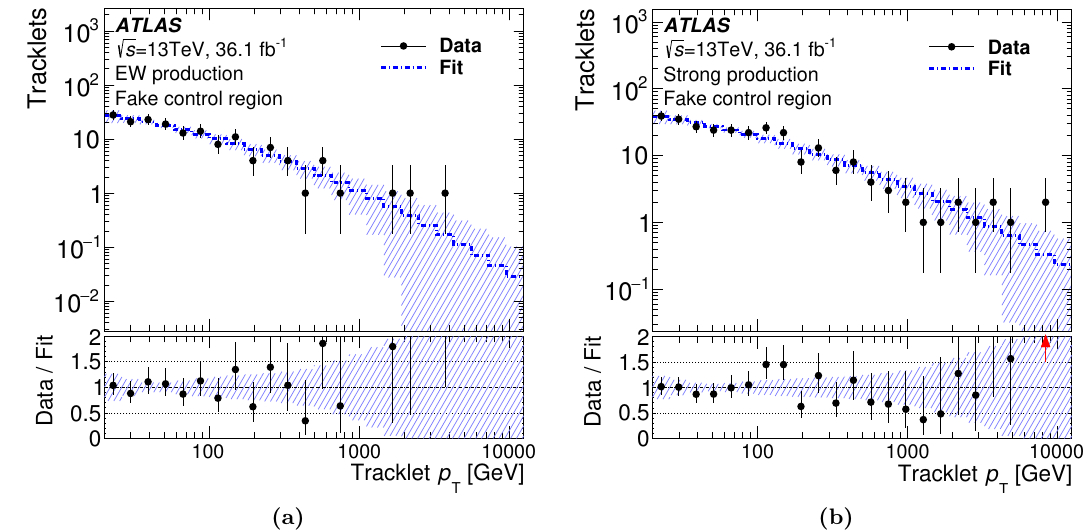
Figure 6 . Fit on the fake-tracklet control sample for (a) the electroweak production channel and (b) the strong production channel. The black markers show data. The blue line and the band show the histogram made from the (cid:12)t function and its uncertainty. The bottom plot shows the ratio of the observed data to the (cid:12)t histogram. The chi-square per degrees of freedom of the (cid:12)t are 5 : 4 = 14 and 8 : 5 = 19 for the electroweak and strong production channels respectively. Red arrows in the Data/Fit ratio indicate bins where the corresponding entry falls outside the plotted